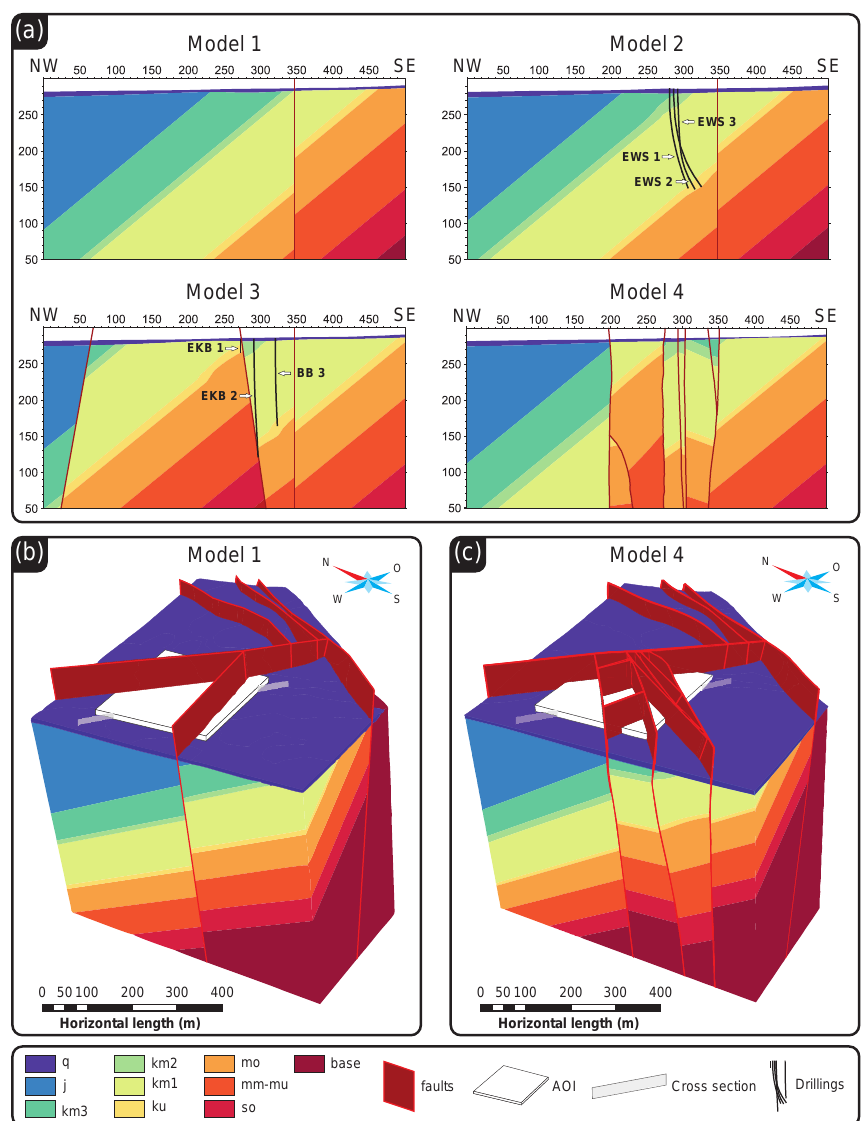
Figure 6. (a) Cross section through the AOI of all four initial geological models with projected borehole tracks (black lines) and 3-D representations of (b) Model 1 and (c) Model